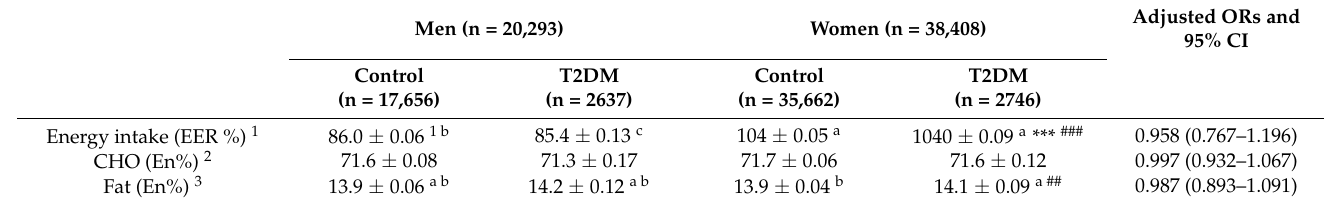
Table 2. Lifestyles and daily nutrient intake according to genders and